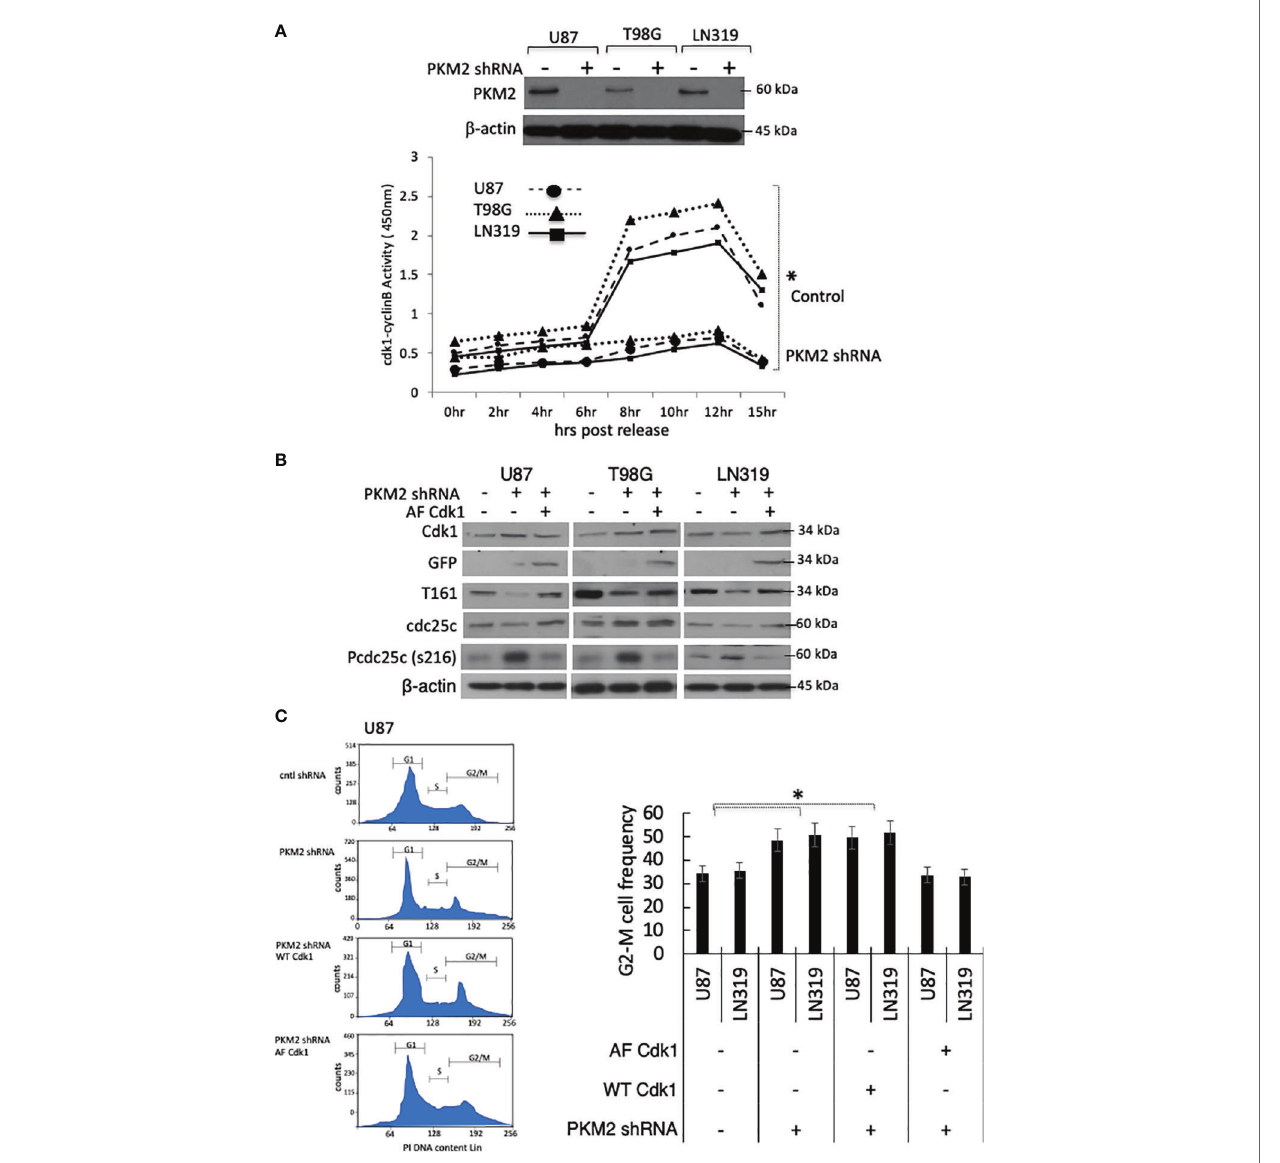
FIGURE 1 | Loss of PKM2 limits Cdk1-cyclinB activation and G2-M cell cycle arrest. (A) U87, T98, or LN319 glioma cells were lentivirally infected with a scrambled shRNA (-) or constructs encoding shRNAs targeting human PKM2 (+). Following drug selection, polyclonal populations were examined by Western blot for PKM2 and b -actin expression. Cdk1-cyclin B activity in lysates from synchronized, serum-stimulated control and PKM2 knock-down U87, T98G and LN319 cells as determined by an in vitro kinase assay. (B) Levels of Cdk1, GFP, pT161 Cdk1, Cdc25C, pS216 Cdc25C and b -actin in total cell lysates from unsynchronized cells expressing scrambled shRNA, or PKM2 shRNA and subsequently manipulated to express a blank or AF Cdk1-encoding construct. (C) The distribution of cells in various phases of the cell cycle was determined by FACS-based analysis on U87 and LN319 cells expressing scrambled shRNA or PKM2 shRNA, and expressing WT or constitutively active (AF) Cdk1. Representative cell cycle plot of all treatment groups of U87 cells in left panel and G2-M values from all treatment group of U87 and LN319 cell lines are presented on the right panel. Values are presented as the mean ± standard error of mean of three determinations. PI, propidium iodide. *p<.05,